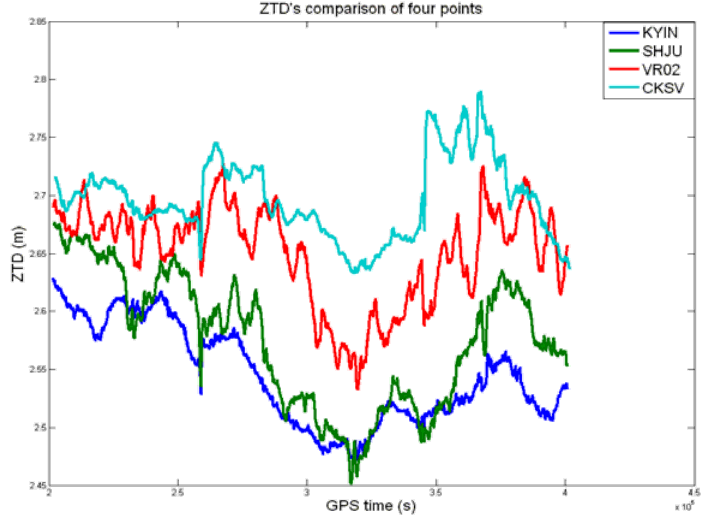
Figure 25. ZTD comparison of e-GPS stations in the north, northwest, southwest, and south during the plum